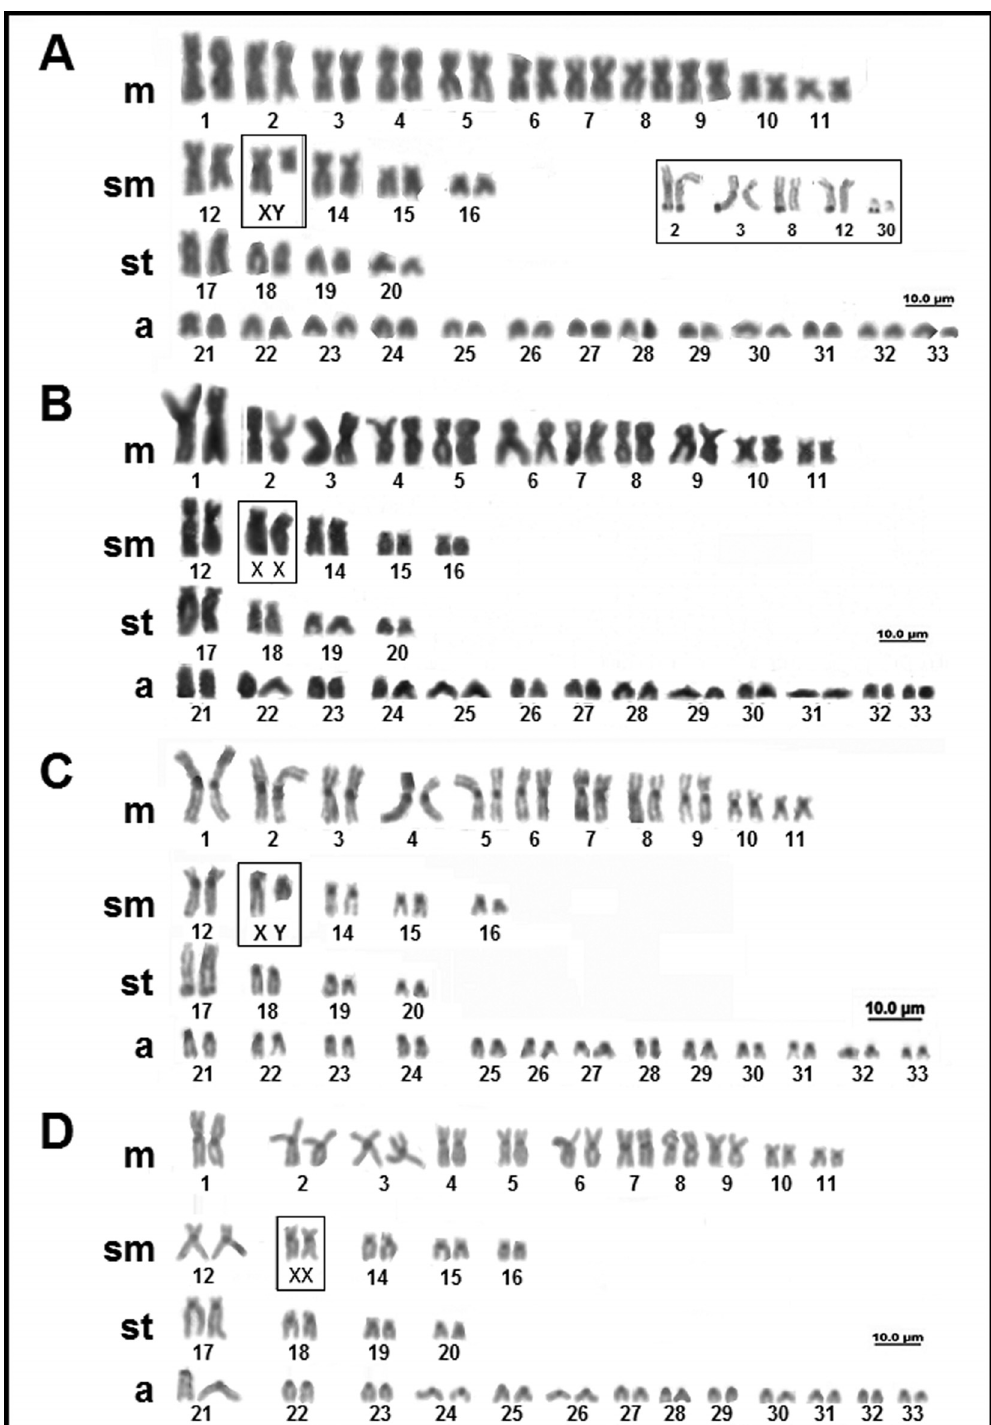
Figure 7 - Karyotypes of Potamotrygon orbignyi : (A) Giemsa staining (male); (B) Giemsa staining (female); (C) C banding (male); (D) C-banding (fe- male); AgNO 3